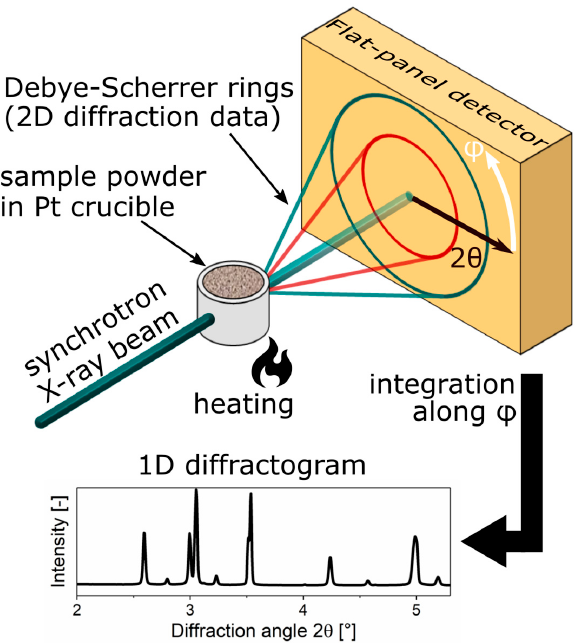
Figure 1. Schematic view of the in-situ powder X-ray diffraction (XRD) experimental setup in Debye-Scherrer geometry at the synchrotron beam line. External heating was applied via inductive heating coils. By azimuthal integration (along ϕ ) of the Debye-Scherrer rings (2D diffraction data), 1D diffractograms were